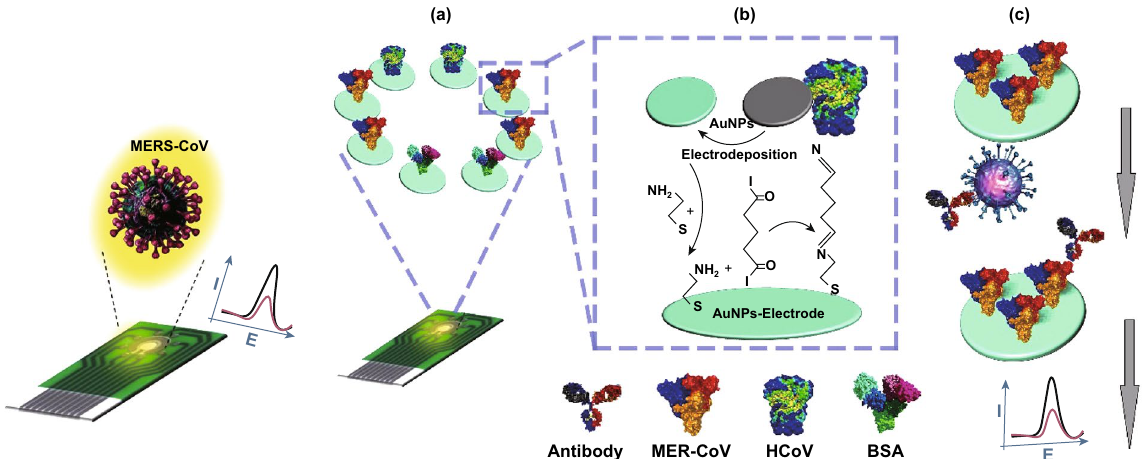
Fig. 13 Scheme demonstrating the MERS‑CoV immunosensor preparation and also the recognition procedure. The biosensor comprises a com‑ petitive immunoassay carried out on DEP array electrodes nanostructured with gold nanoparticles to allow the multiplexed recognition of vari‑ ous CoV. a Immunosensor array chip for coronavirus. b Stages of immunosensor construction. c Recognition procedure of competitive immu‑ nosensor for the virus. Redrawn from Ref.